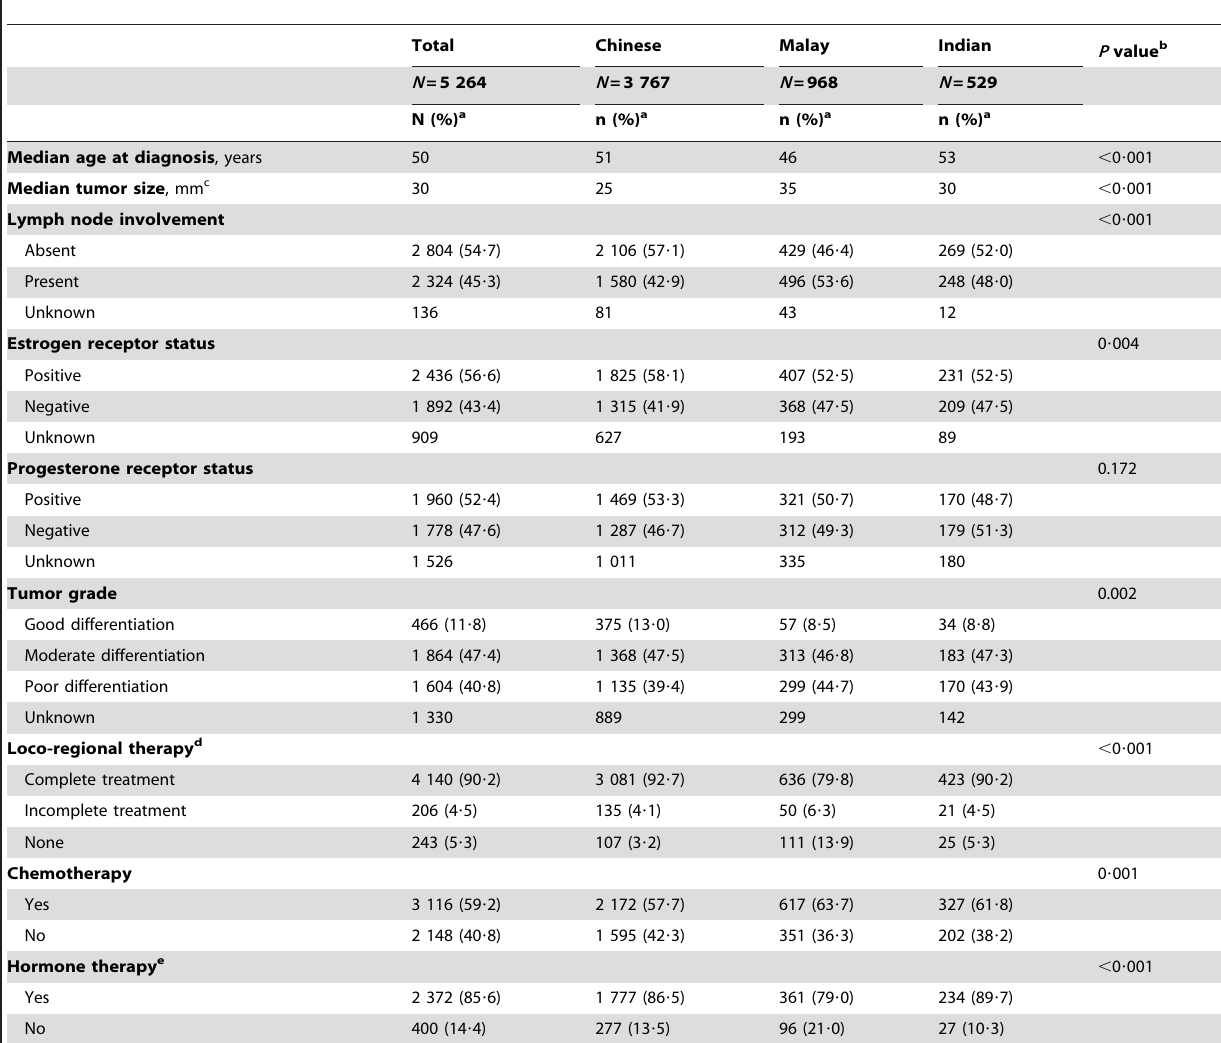
Table 1. Distribution of Patient Profile, Tumor Characteristics and Treatment According to Ethnicity in 5,264 Southeast Asian Women with Breast